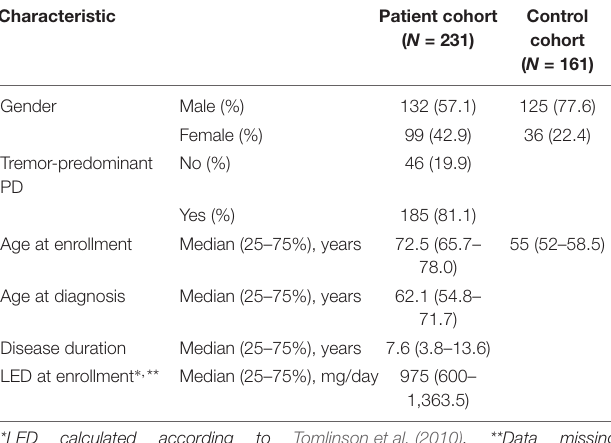
TABLE 2 | Patient and control cohort